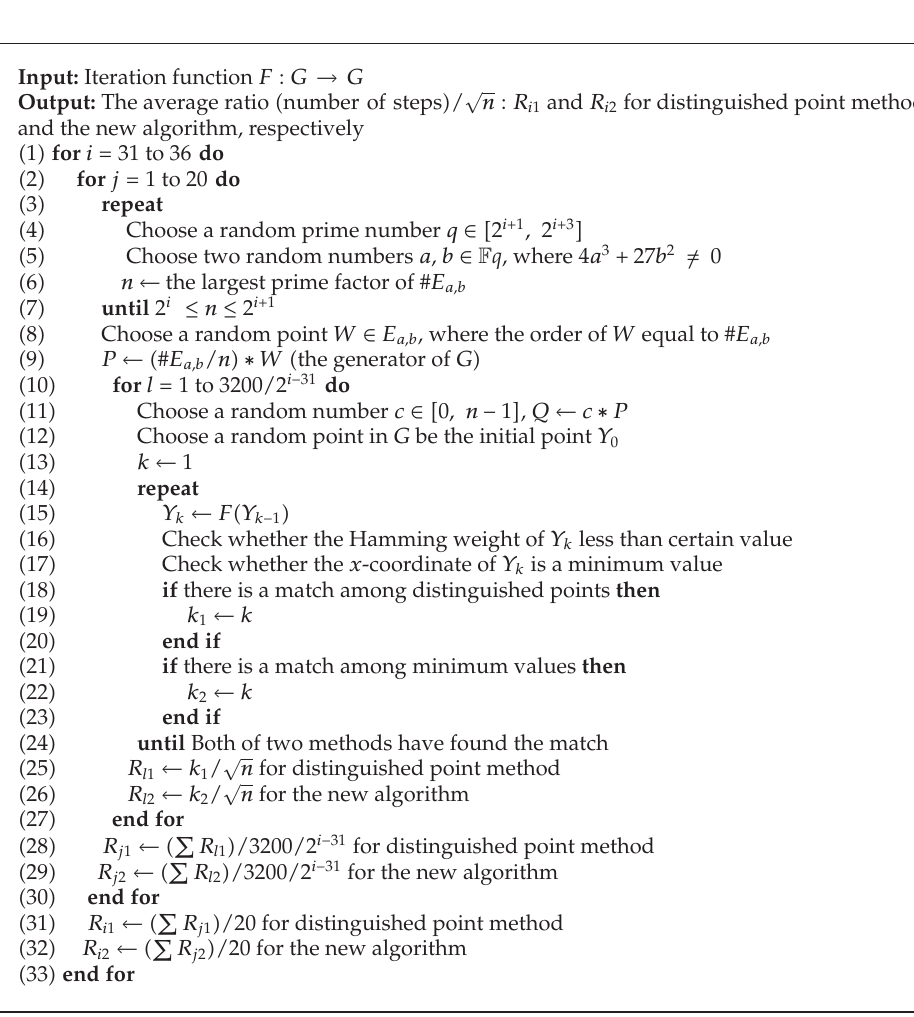
Algorithm 2: Experiments for distinguished point method and the new